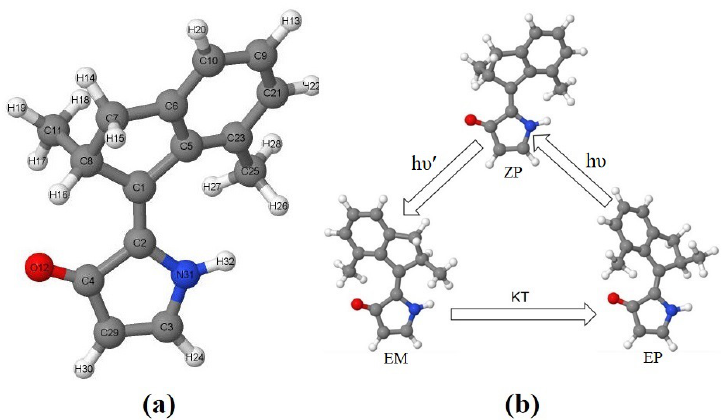
Figure 1. ( a ) Optimized geometry of the ZP isomer of DDIY. All atoms are labelled. ( b ) The schematic diagram of a working cycle of the three-step LDMRM DDIY. All geometries are optimized at the OM2/MRCI